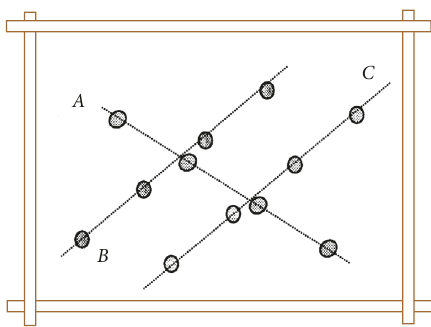
Figure 3: Resistivity using four electrodes at various spots in the same area to minimize influence of rebars